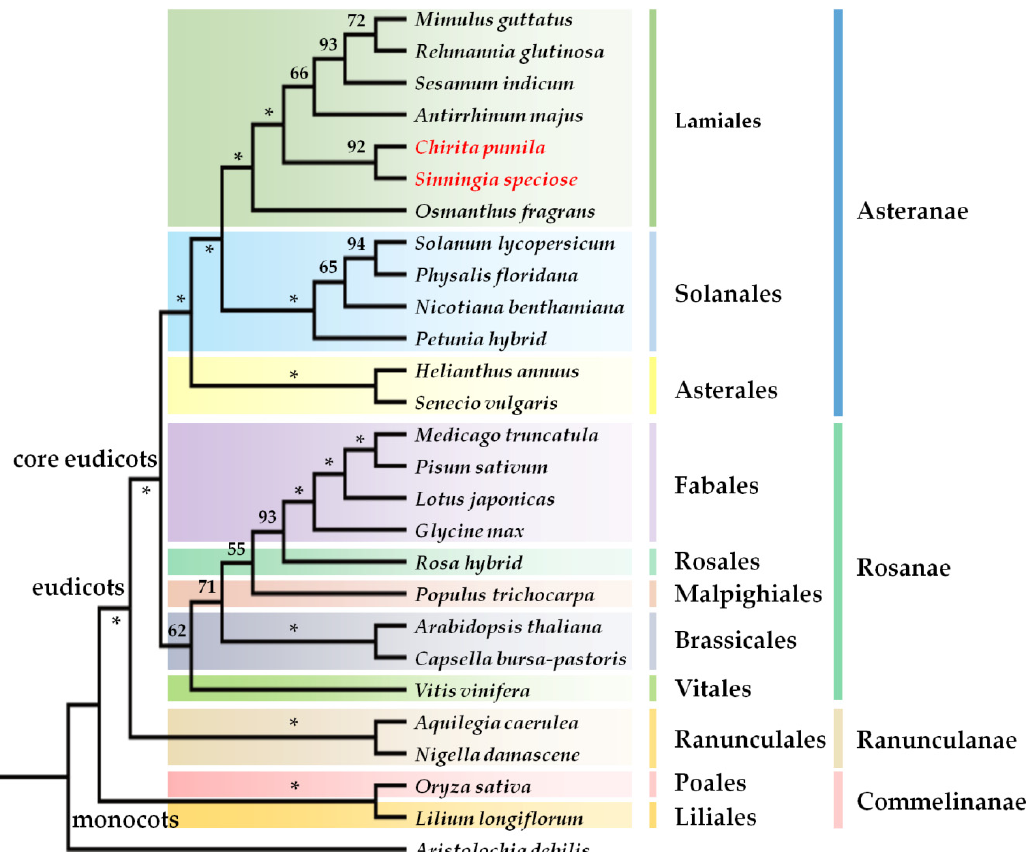
Figure 1. The strict consensus tree showing relative positions of major model systems. The tree is generated from datasets of combined rbcl , matk and ndhf data. Bootstrap values are labeled above the branches. The asterisk indicates 100% support. The species in red font indicate two representatives of Gesneriaceae.